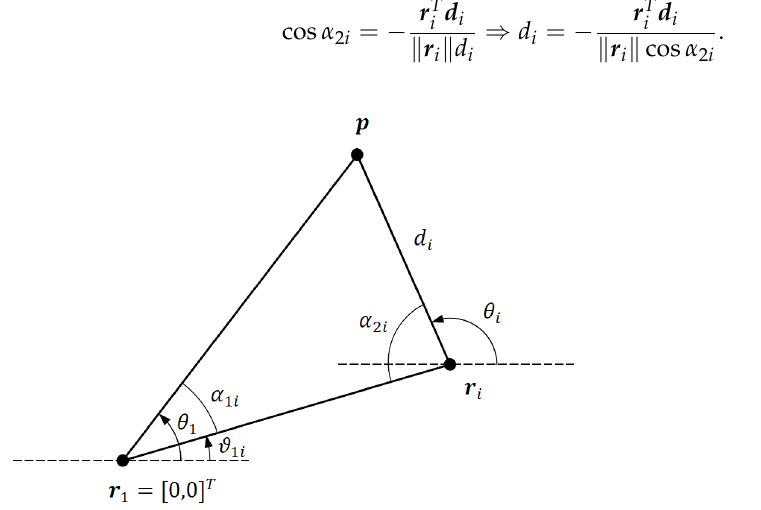
Figure 2. Triangle formed by corner points p , r 1 and r i